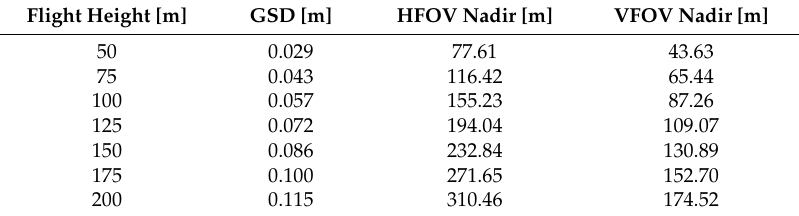
Table 2. Calculated GSD and FOV for GoPro action camera in